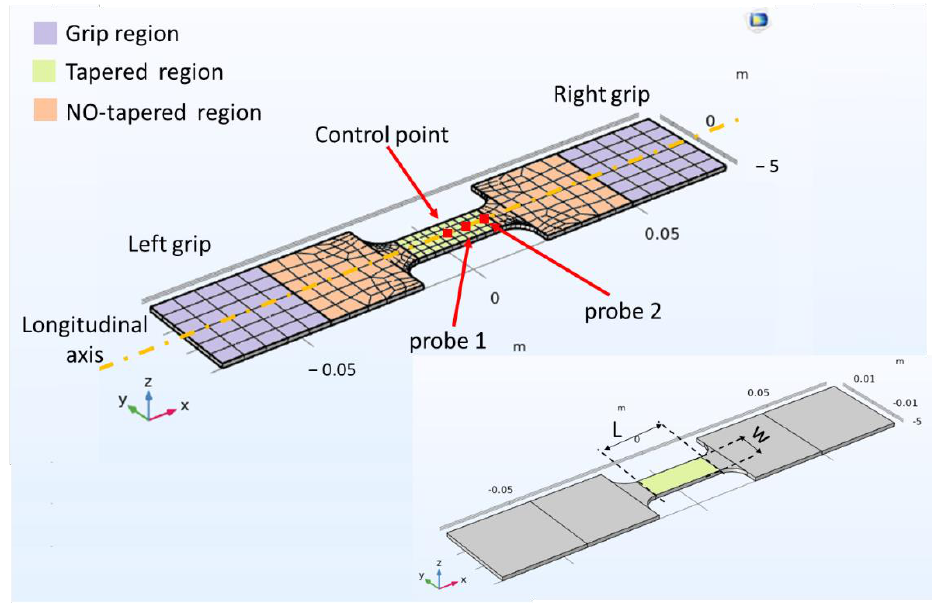
Figure 3. Geometry of sample designed in FE model.